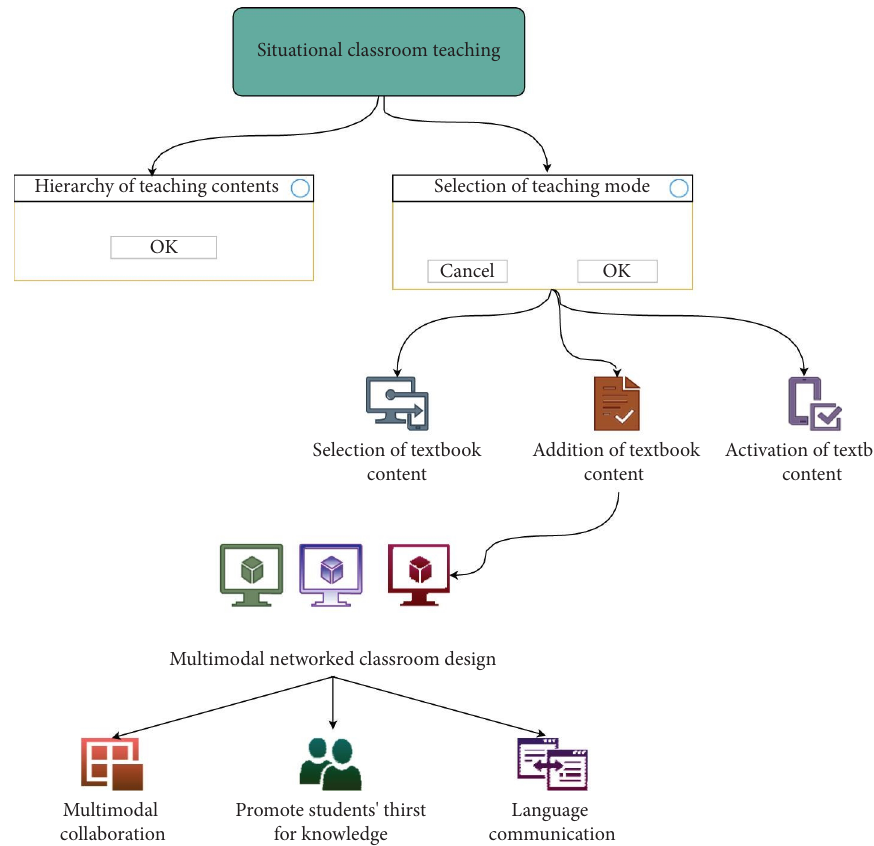
Figure 2: Flow chart of situational classroom